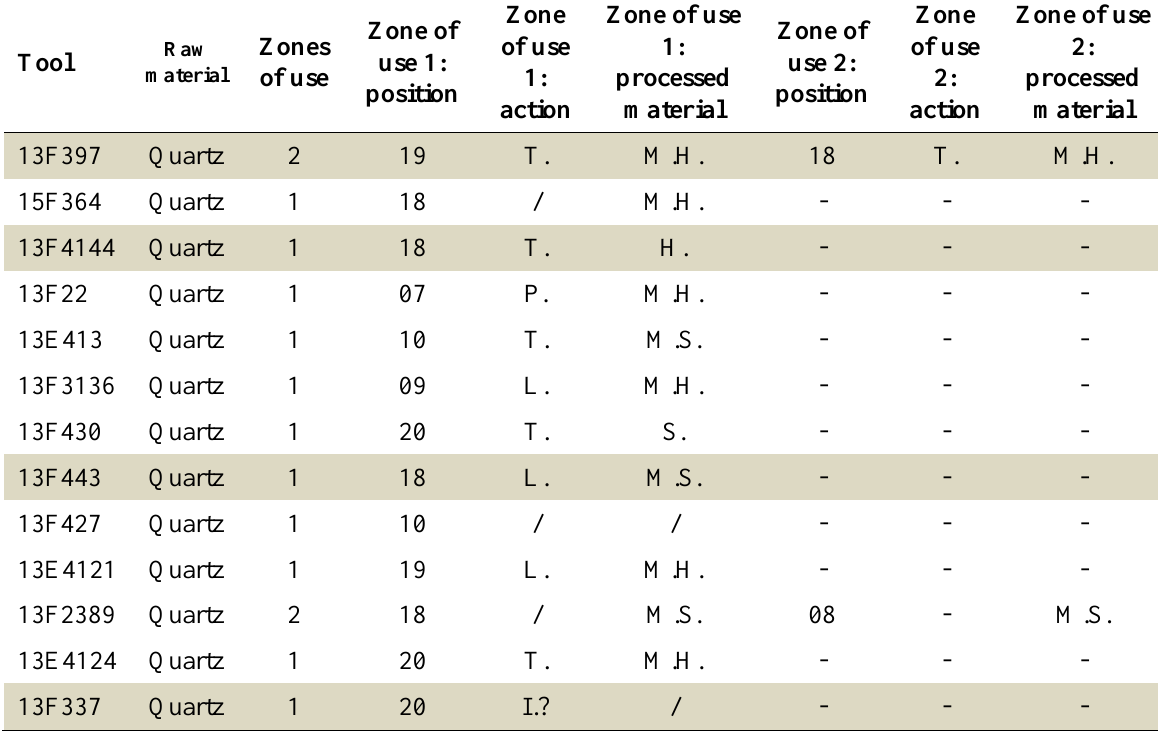
Table 2. Ciota Ciara cave. Results of the use-wear analysis performed on the artefacts of S.U. 13. The position of the traces identified is referred to the scheme made by Van Gijn (1989) and modified by Berruti (Berruti & Arzarello 2012). Action: T = Transversal; P = Perforation; L = Longitudinal; I = Impact. Worked materials: H. =